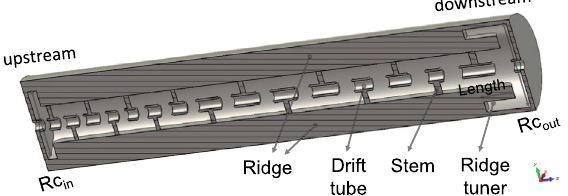
FIG. 4. Three-dimensional model of IH cavity in CST MW Studio calculation.